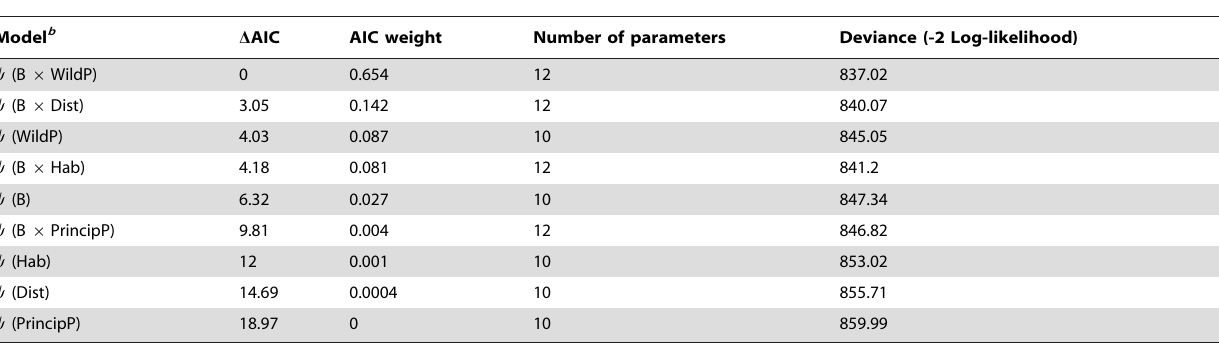
Table 3. Effect of covariates a on occupancy ( ^ yy